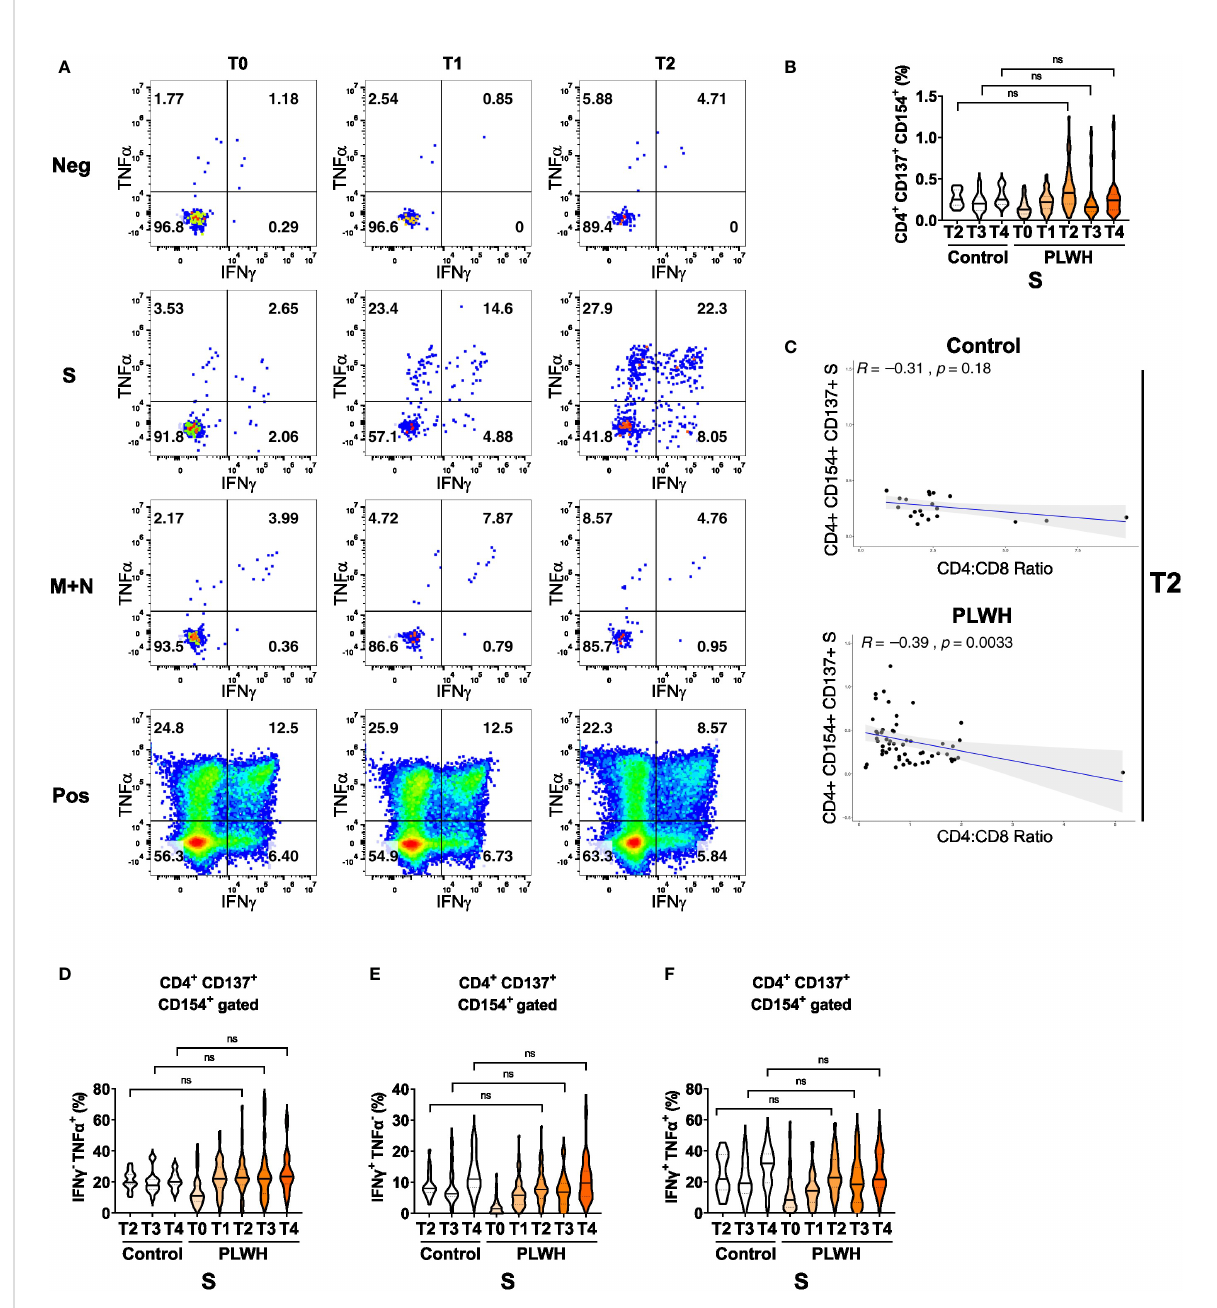
FIGURE 3 Antigen-dependent responses of CD4+ helper T cells in vaccinated PLWH and HIV-negative controls. (A) Representative dot plots of TNF a and IFN g expression in activated CD4+ CD137+ CD154+ T cells of a PLWH donor stimulated with SARS-CoV-2 spike (S) glycoprotein peptide pool, or with membrane glycoprotein plus nucleocapsid phosphoprotein (M+N) peptide pool, or with CytoStim ™ (Pos), or left untreated (Neg) before and after vaccination shots. (B) The violin plot represents frequency of activated, i.e. CD137+ CD154+, CD4+ T cells and (C) their correlation (spearman method) with CD4:CD8 ratio from control subjects (upper scatter plot) and PLWH (lower scatter plot). The violin plots represent (D) frequency of TNF a + cells in activated CD4+ CD137+ CD154+ T cells, (E) frequency of IFN g + cells in activated CD4+ CD137+ CD154+ T cells and (F) frequency of TNF a + IFN g + double-positive cells in activated CD4+ CD137+ CD154+ T cells at the indicated time points. Statistical signi fi cance was calculated by two-tailed Mann-Whitney test: ns, not signi fi cant (PLWH T0, n = 64-65; PLWH T1, n = 54; PLWH T2, n = 59-61; PLWH T3 & T4, n = 29; Control T2, n = 20; Control T3 &T4, n =